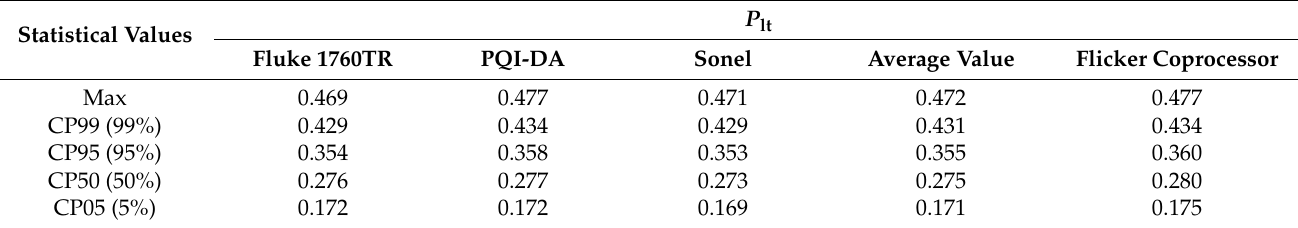
Table 12. Statistical values calculated for the recorded P lt values by the PQ analysers and flicker coprocessor. Statistical